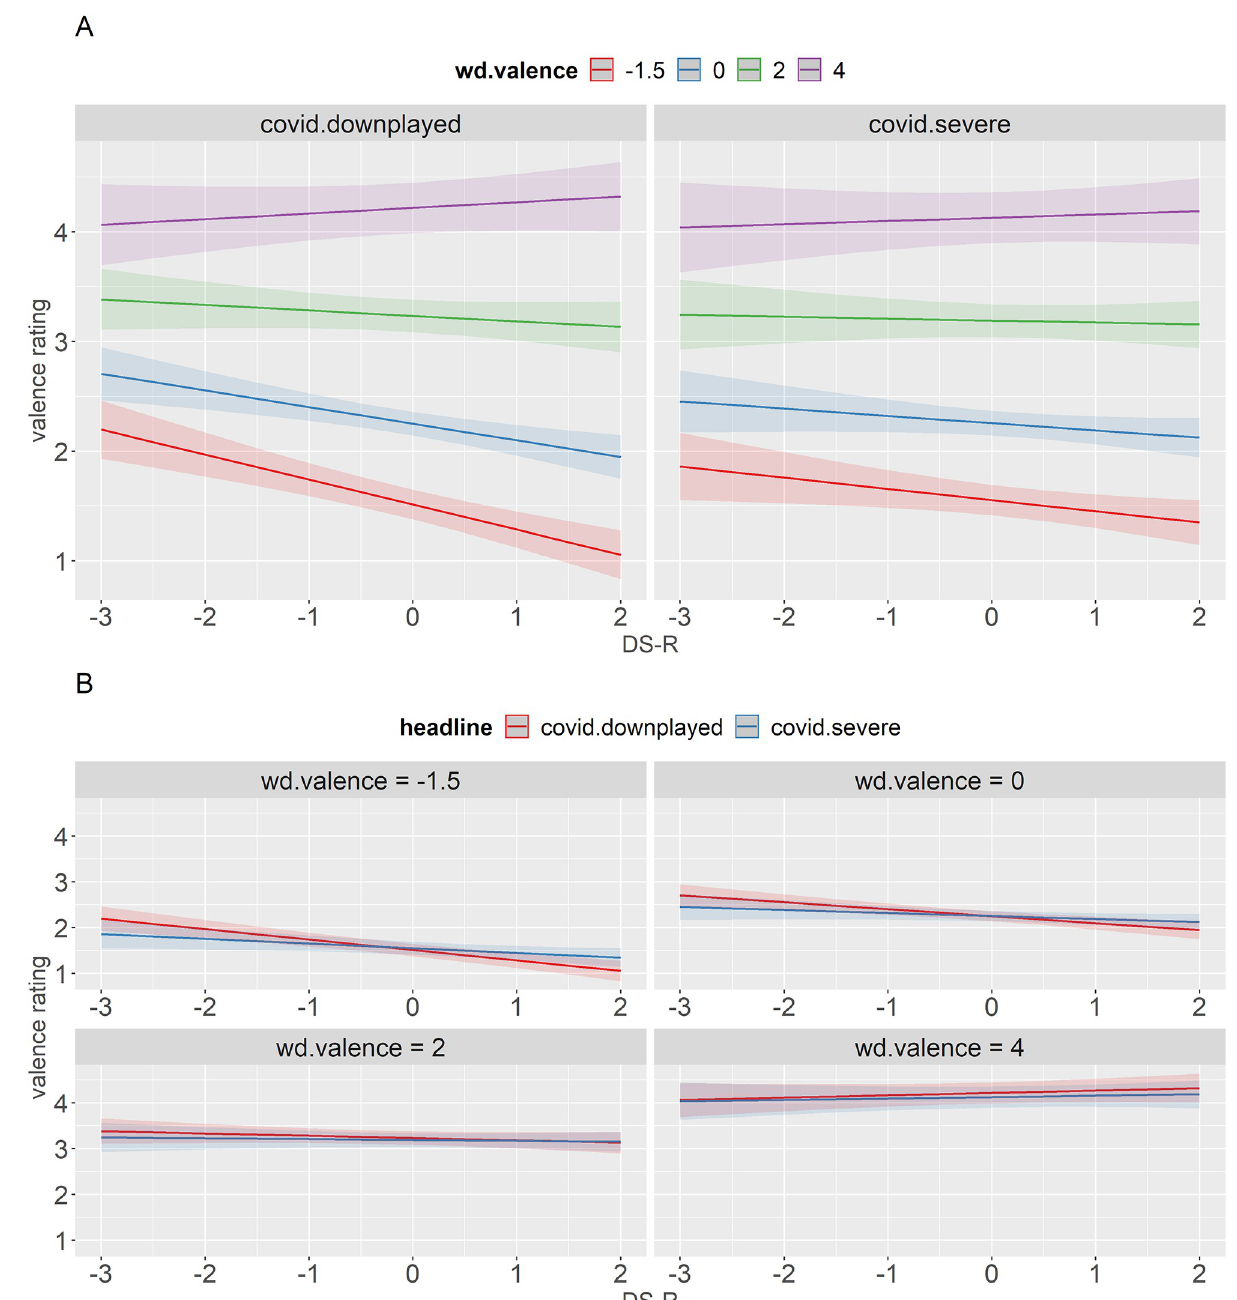
Fig 3. Predicted values (marginal effects) of the interaction between DS-R, word valence, and headline with valence rating as a dependent variable. Panel A shows a breakdown by headline, Panel B shows a breakdown by word valence.